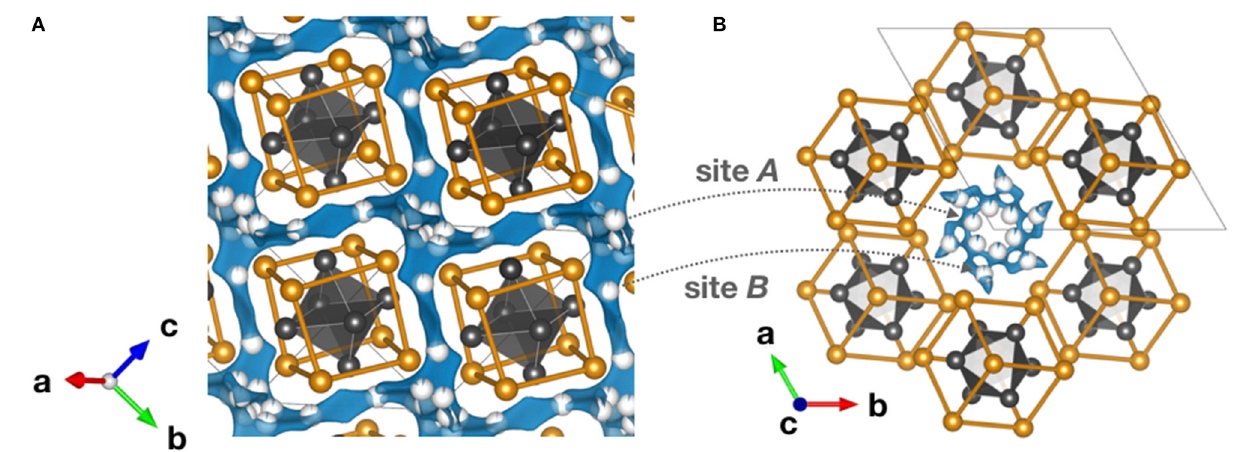
FIGURE 7 | Bond valence energy landscape (blue) for Al 3 + intercalated chevrel Mo 6 S 8 (ICSD #158986 with cell parameters from Levi et al., 2007). They are drawn at energy thresholds of (A) 0.33eV to show the whole path and (B) 0.23eV to show the match of the sites suggested by the bond valence method and Al sites (partially blue) reported in literature. S anions forming cubic cages are marked orange, while the enclosed Mo 6 octahedra and the unit cell are gray. In (B) the six atomic sites of the inner and the six of the outer rings are illustrated. The calculations were performed using the program softBV ( Adams and Rao,